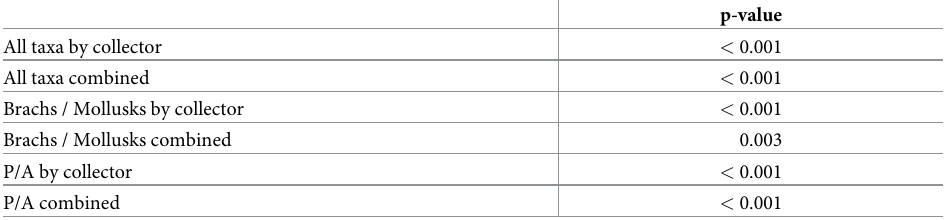
Table 3. PERMANOVA results.